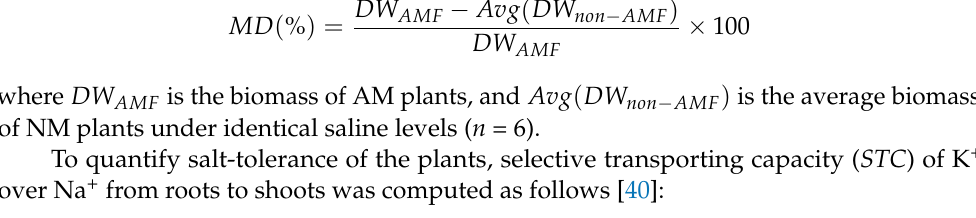
Figure 2. Effects of arbuscular mycorrhizal fungi on total dry weight ( A ) and root:shoot ratio ( B ) of Cinnamomum camphora plants under 0, 50, and 200 mM NaCl. NM, Fm, Ri, and Fm+Ri represent the four mycorrhizal treatments: inoculation with sterilized mycorrhizal fungi, with Funneliformis mosseae or Rhizophagus irregularis, either alone or in combination, respectively. Values are presented as the mean ± SE ( n = 6). Different lowercase letters indicate a significant difference according to LSD at p < 0.05.